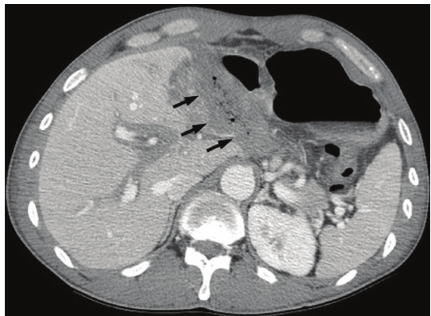
Figure 2: Abdominal computed tomography scan obtained after administrationofcontrastmaterialshowsmildbiliarytreedilatation and a fluid collection with some air bubbles